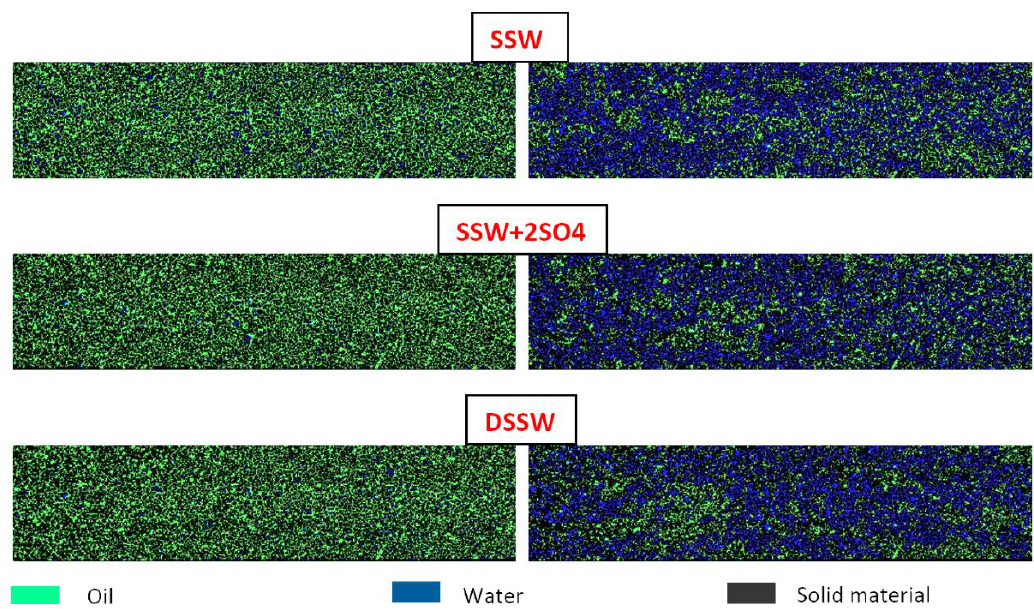
Figure 18. Real-structure water-wet micromodels used for three injection brines mentioned in Table 2. Figures on the left side represent the oil initialization; while on the right side represent the oil recovery after 10 PV brines flooded. Table 12. Summary of real structure water-wet micromodel with initial oil saturation, connate water saturation and final oil recovery factors.